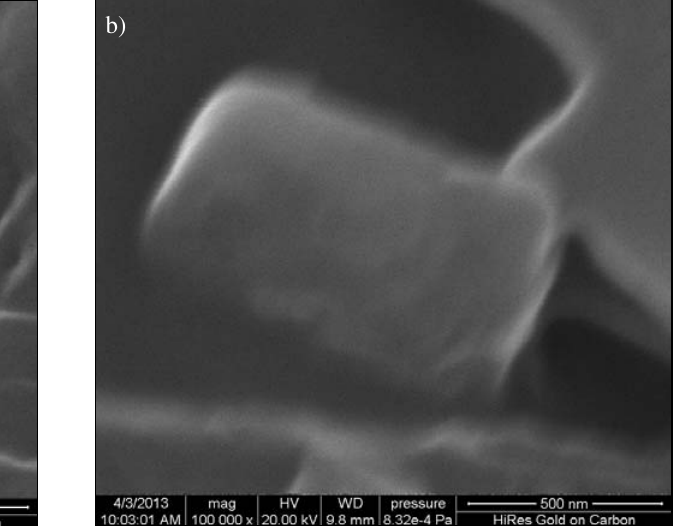
Fig. 1. SEM images of compound